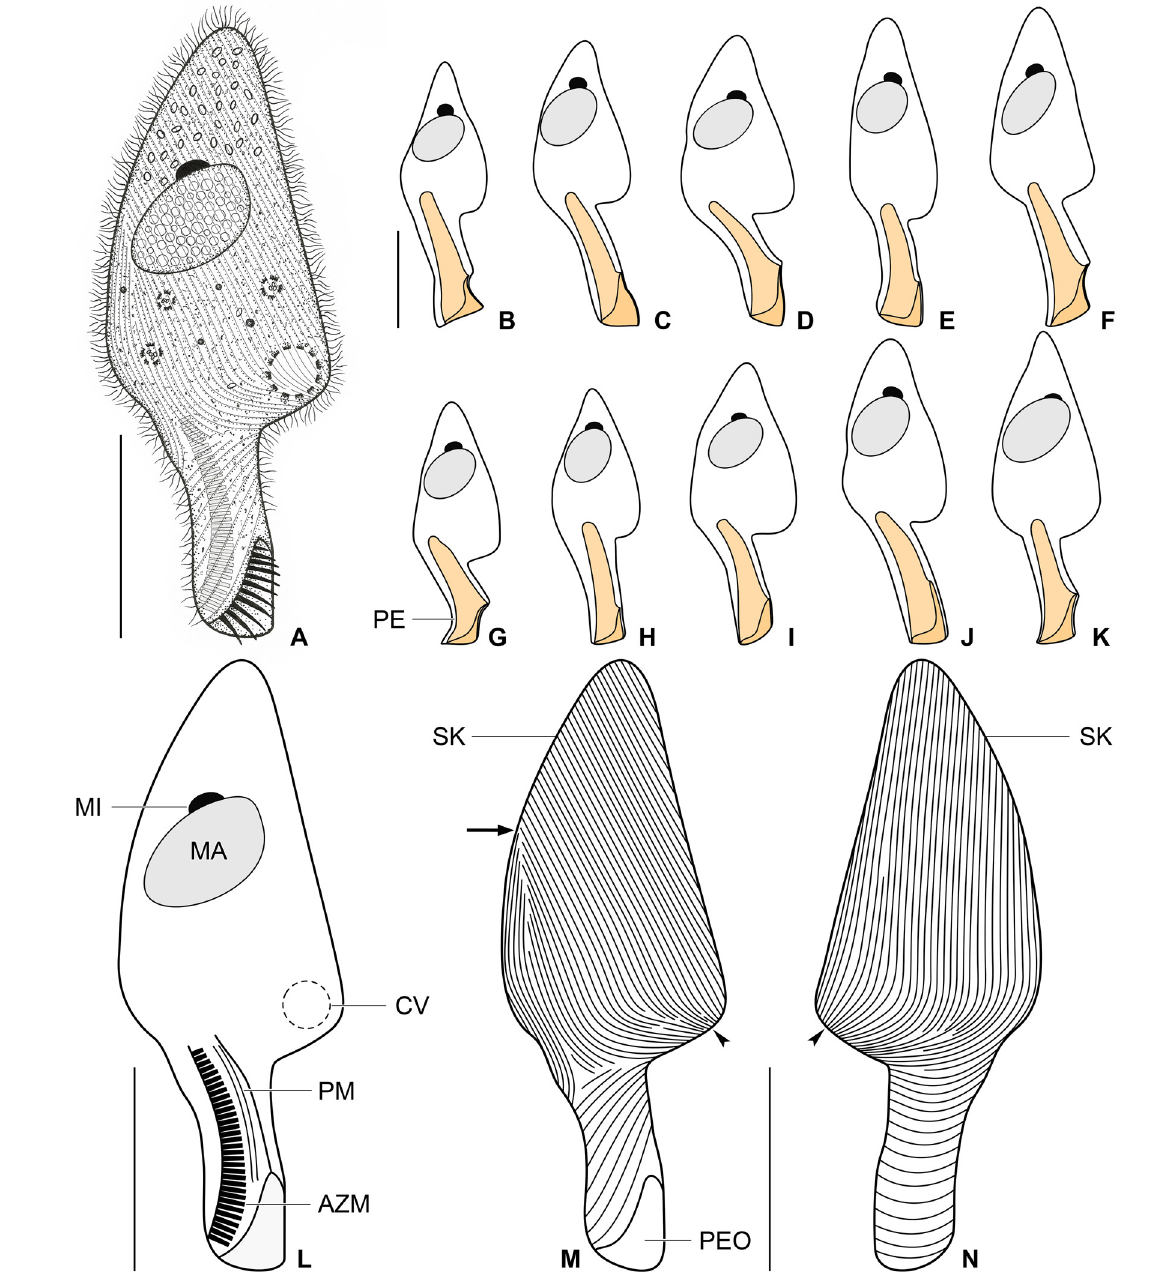
Fig. 4. Clevelandella hastula (Kidder, 1937). Vietnamese specimens isolated from Panesthia angustipennis cognata Bey-Bienko, 1969 from life (A) and after protargol impregnation (B–N). A . Ventral view of a representative specimen, length 90 μm. B–K . Variability of body shape and size as well as of the nuclear (shaded grey) and oral (shaded yellow) apparatus. L . Semi-schematic diagram, showing the general body organization. M–N . Ciliary pattern of ventral and dorsal sides. Arrow marks the right suture and black arrowheads denote the position of the ciliary whorl (posterior suture). Scale bars = 30